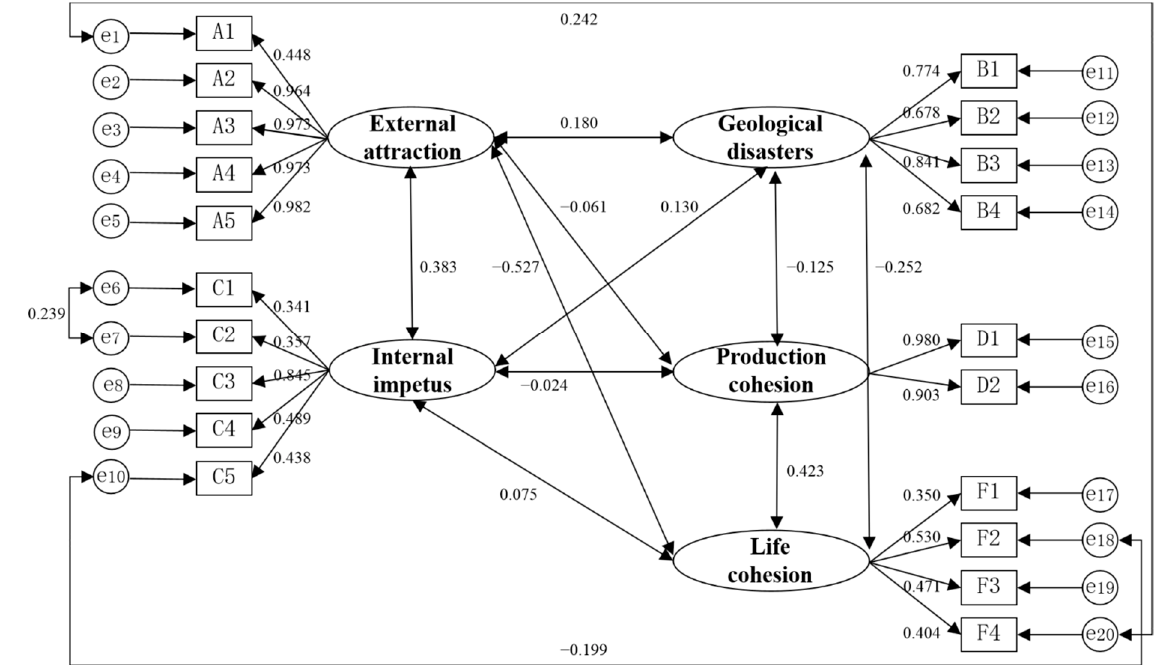
Figure 4. Revised path of the model. Table 5. Model adaptation indices.